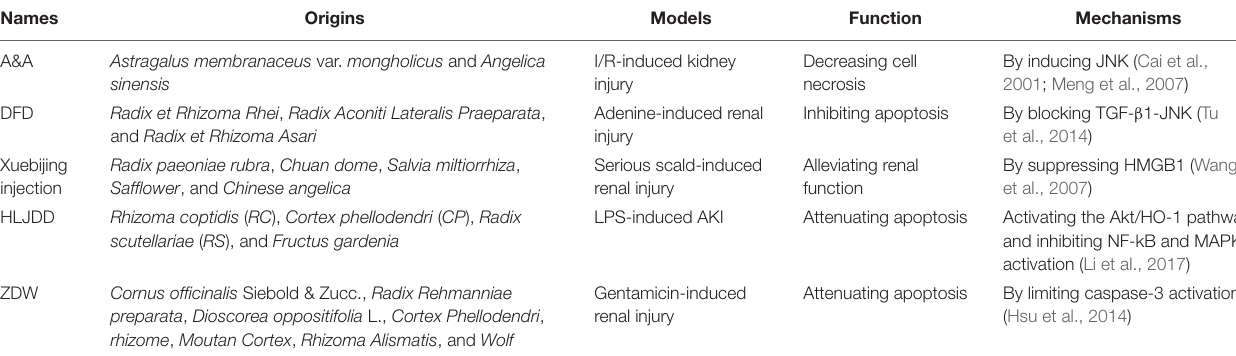
TABLE 1 | Application of TCM Preparations in the treatment of acute kidney